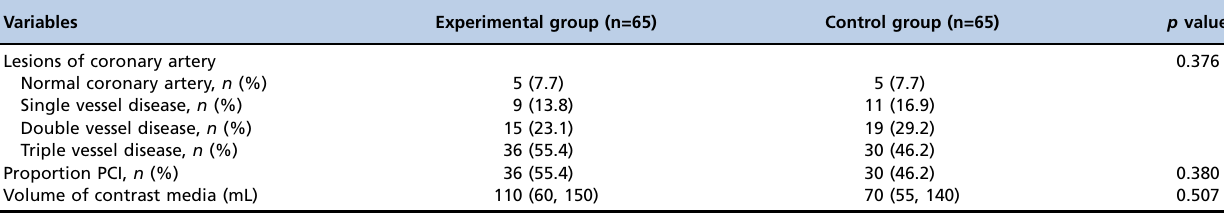
Table 2 - Comparison of coronary artery angiography results between the two